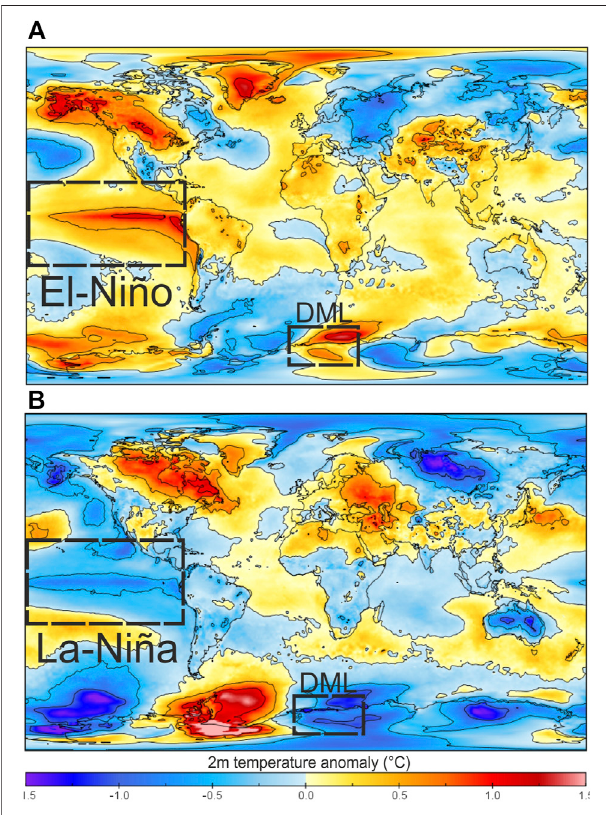
FIGURE 7 | Composite ERA5 surface air temperature anomaly map for the (A) El Niño and (B) La Niña years. During El Niño years, the ERA5 surface air temperature anomaly shows a positive anomaly, whereas the opposite is observed during La Niña years over the DML region.